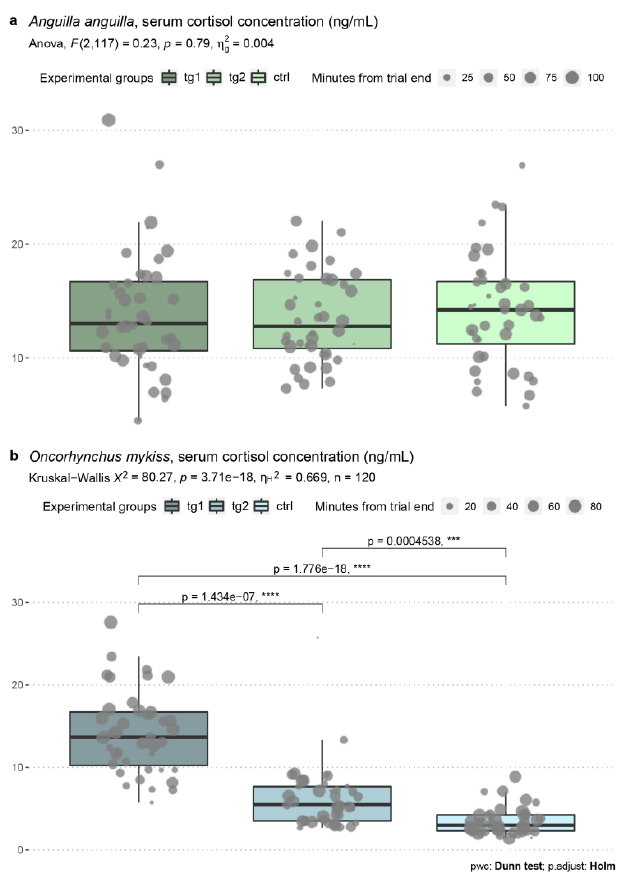
Figure 2. Concentrations of serum cortisol (ng mL −1 ) quantified in A. anguilla ( a ) and O. mykiss ( b ), with details of statistical analyses. Experimental groups are color coded, and points overlaid on box-plots reflect time in minutes elapsed from the end of trial to sampling operations. Post hoc testing was performed only in case the main effect was statistically significant ( p < 0.05). η g2 : generalized eta squared; η H2 : eta squared based on the H-statistic; pwc: pairwise comparison; asterisks denote degree of statistical